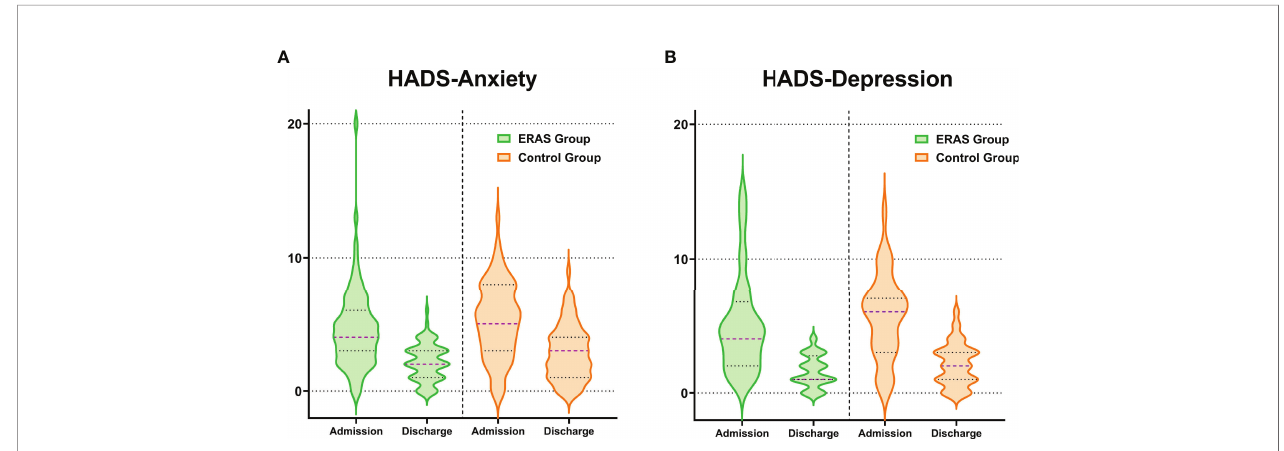
FIGURE 4 | Distribution of changes in HADS-anxiety (A) and HADS-depression (B) scores at hospital admission and discharge strati fi ed by group